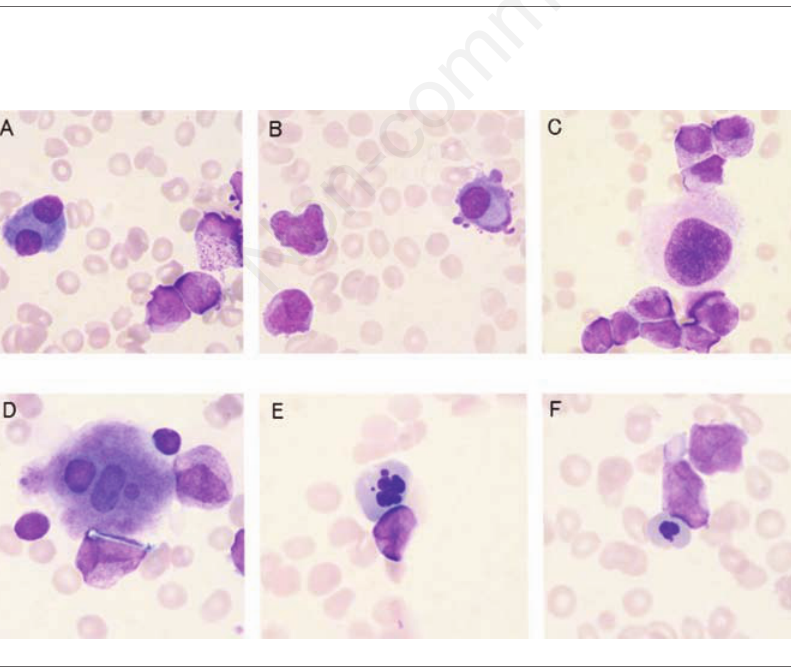
Figure 3. Atypical cells in bone marrow smear (May-Giemsa staining). A) and B) micro megakaryocytes; C) megakryocyte with non-lobulated nucleus; D) megakaryocyte with isolated multi-nuclei; E) erythroblast showing karyorrhexis; F) erythroblast with a nucle- us showing abnormal